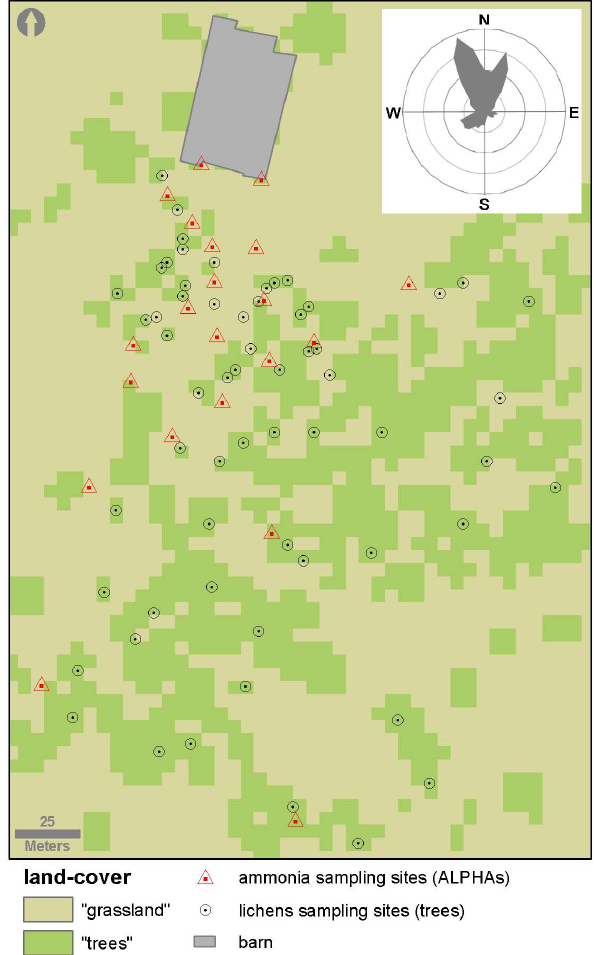
Fig. 1. Sampling design and wind direction. In cork-oak wood- land we assessed lichen functional diversity, measured atmospheric ammonia concentration over one year period, and modelled N depo- sition using LADD model considering the land-cover (“trees” and “grass”), the wind direction and considering the barn as the source of N. The wind direction is the % of wind occurrence from each direction in 10 ◦ interval, during the sampling period. The full circle is